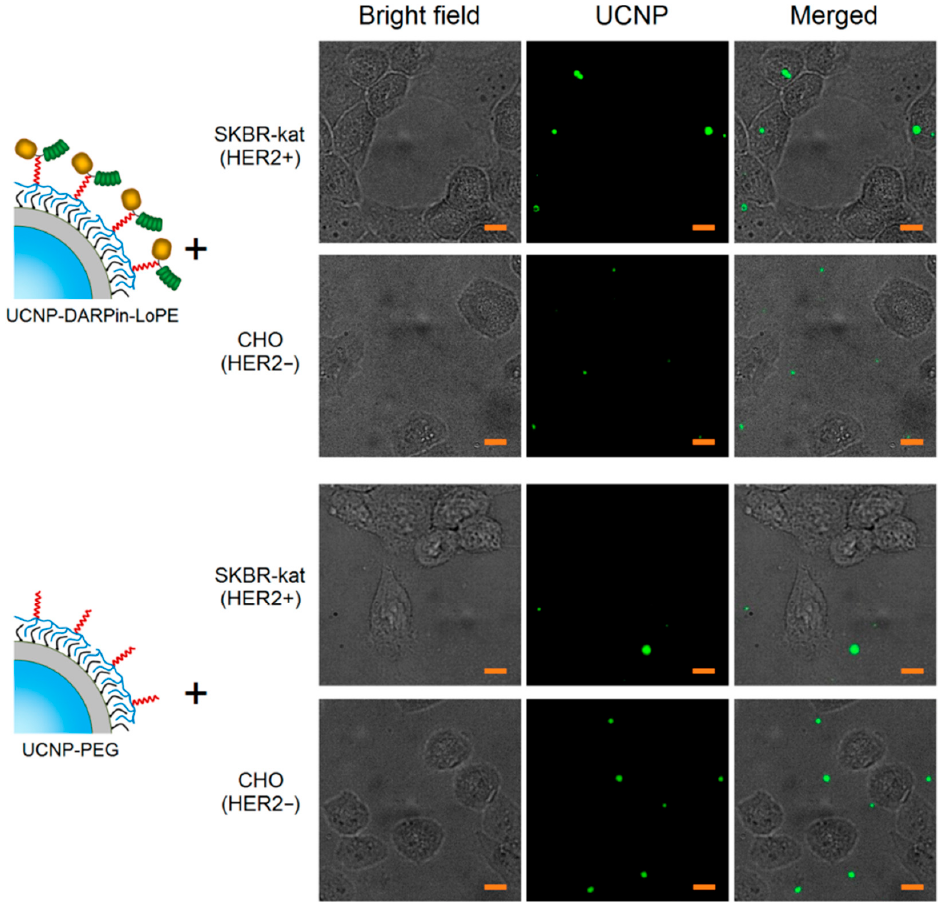
Figure 2. Microscopic images of SKBR-kat and CHO cells incubated with non-targeted UCNP-PEG and UCNP-DARPin-LoPE theranostic nanocomplexes. UCNP–PL signal in the range of 420–840 nm, excitation on 980 nm. The scale section is 10 μ m. Molecules 2020 , 25 , x FOR PEER REVIEW